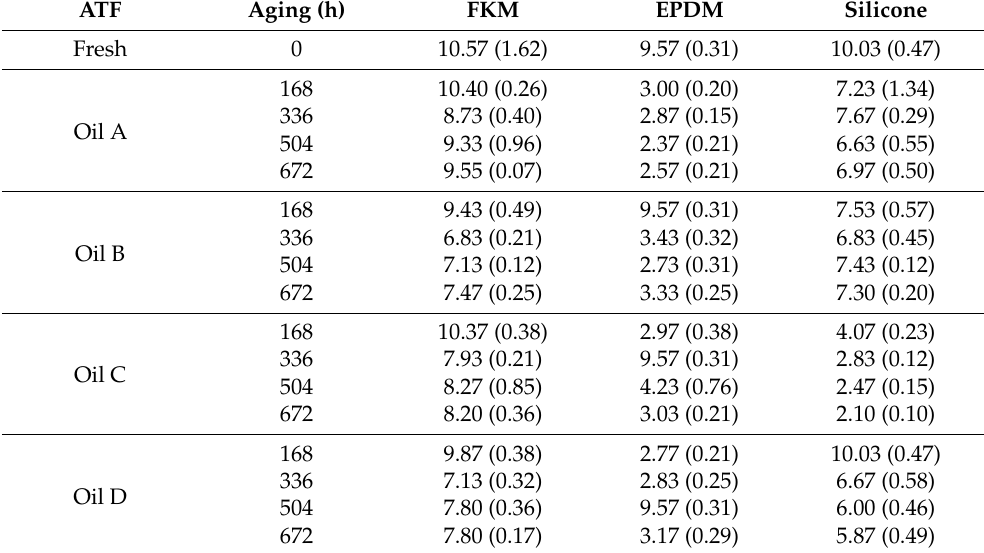
Table 4. Tensile strength (MPa) and standard deviation (in brackets) for the different elastomers and different aging times and ATFs. ATF Aging (h) FKM EPDM Silicone Fresh